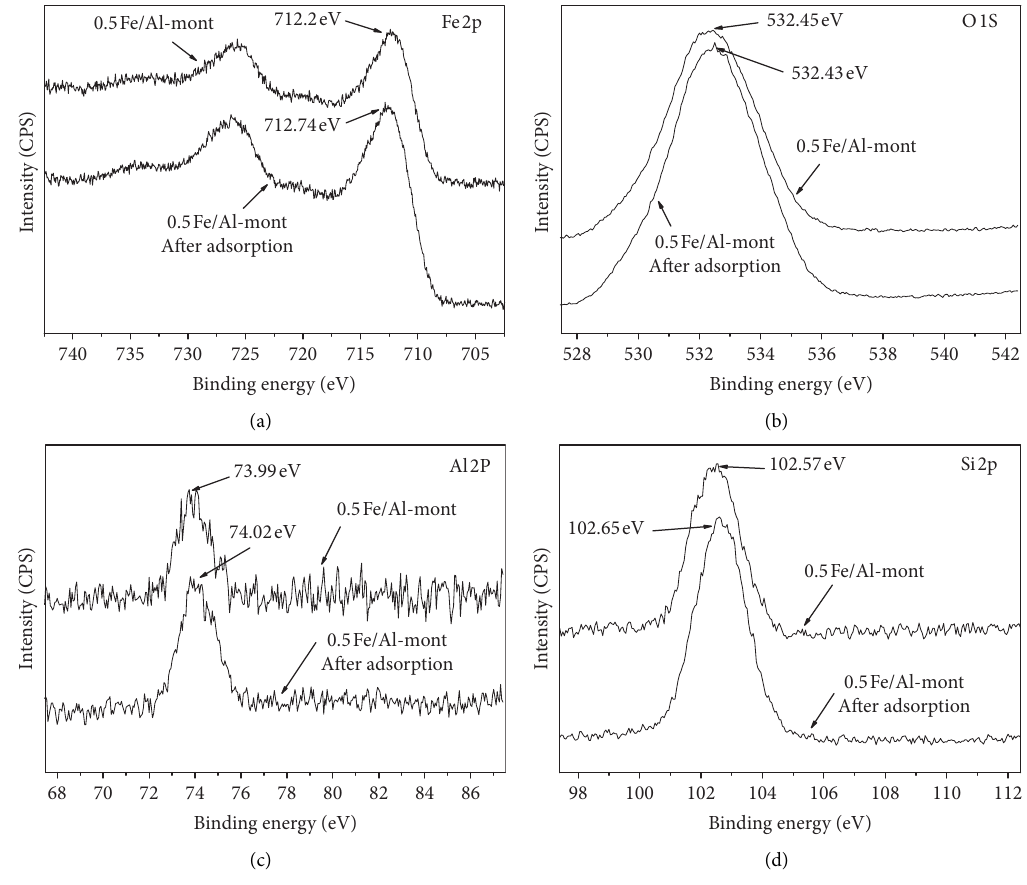
Figure 7: XPS of O1s, Al 2p, Si 2p, and Fe 2p of